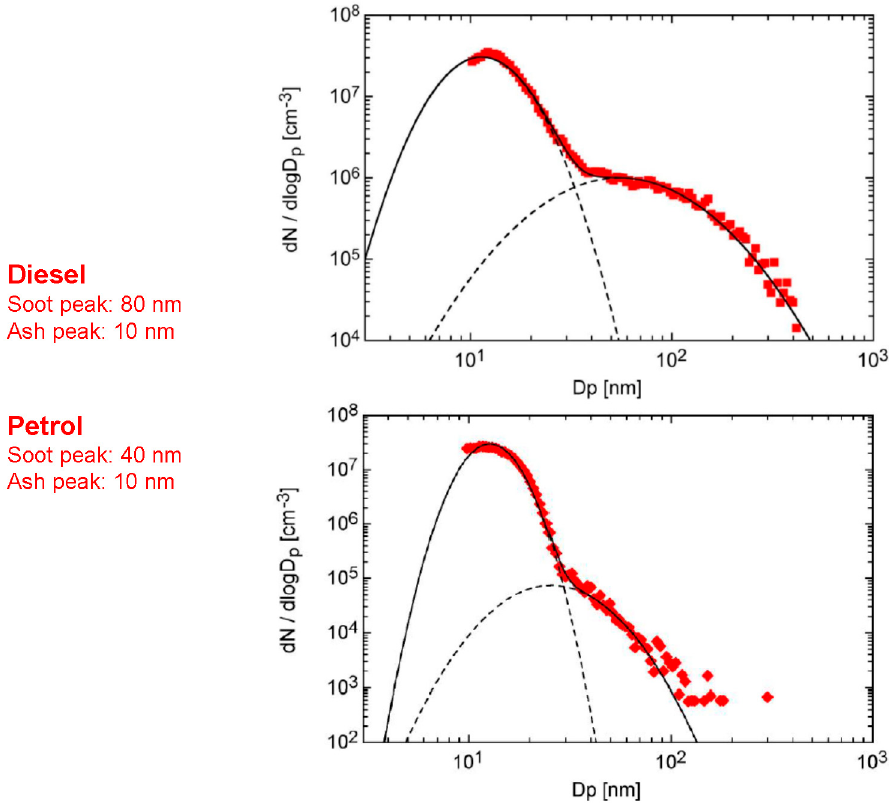
Figure 2. Internal combustion engine particle emissions; diesel ( top ) and petrol or gasoline ( bottom ).